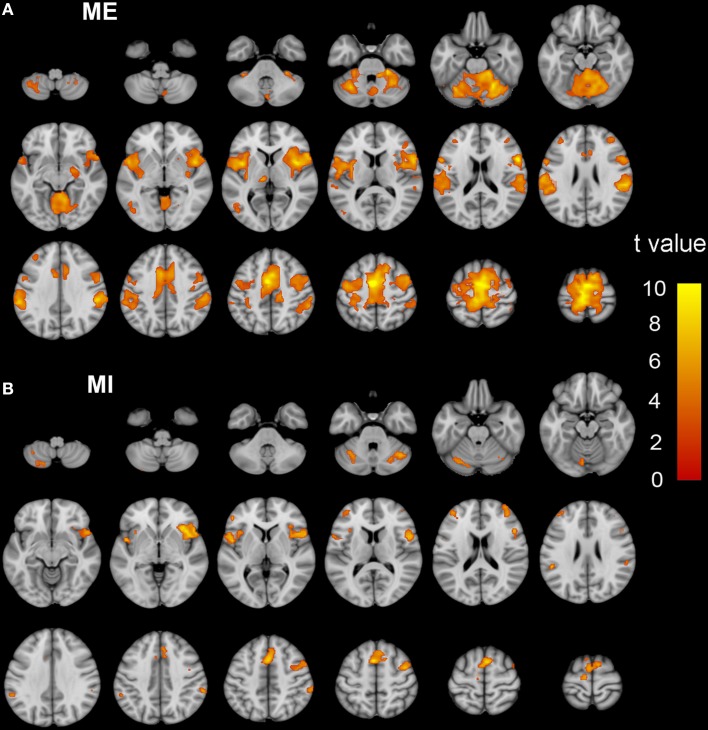
The activation patterns of the ME and MI tasks in ISCI patients. Typical brain regions with activation during the ME task are shown in (A), while brain regions with activation during an MI task are shown in (B). Significant activation was considered when the voxel-wise threshold was q < 0.01 (FDR correction) and the cluster ≥30 voxels. The right side of the image corresponds to the right hemisphere. The color bar represents the t-values. ME, motor execution; MI, motor imagery; ISCI, incomplete spinal cord injury.